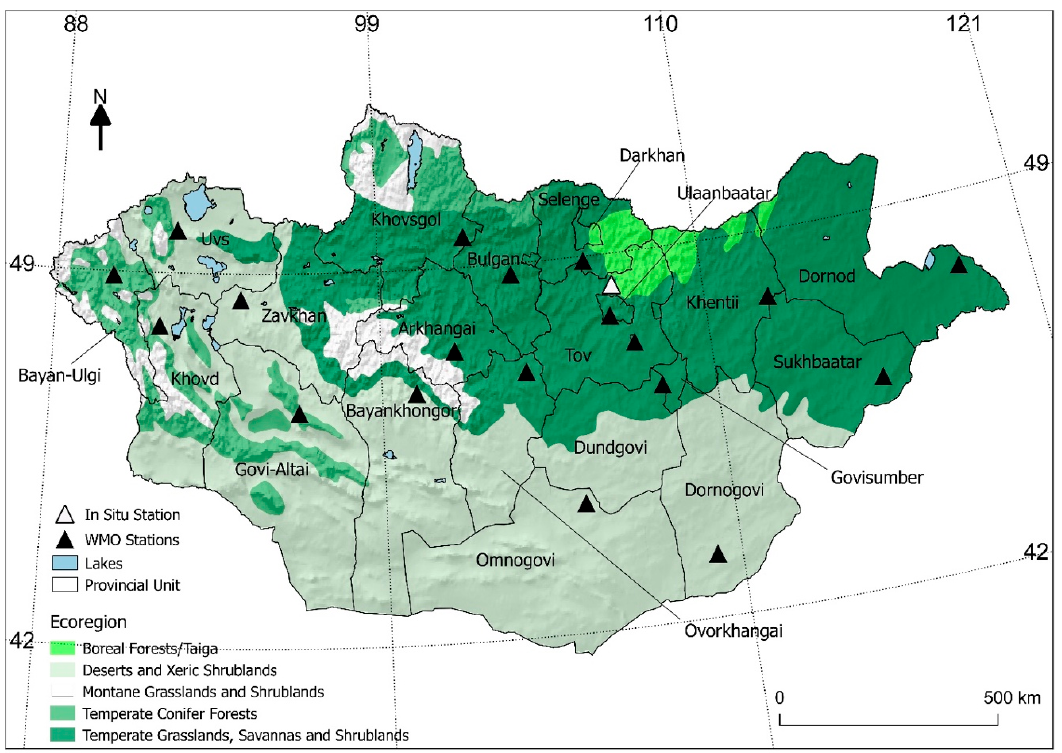
Figure 1. Reference map of Mongolia including the in situ climate station at Sugnugur Valley and other surface weather (WMO) stations. World Wildlife Federation (WWF) ecoregions and the boundaries of provincial units (i.e., aimags) are also shown.